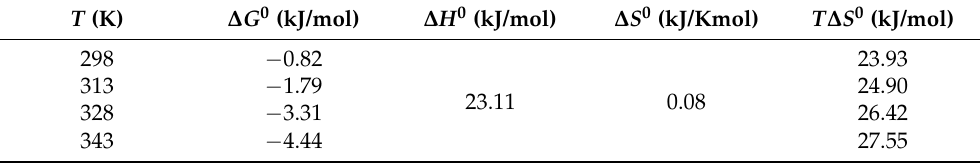
Table 5. Thermodynamic parameters for chromium sorption by Fe 3 O 4